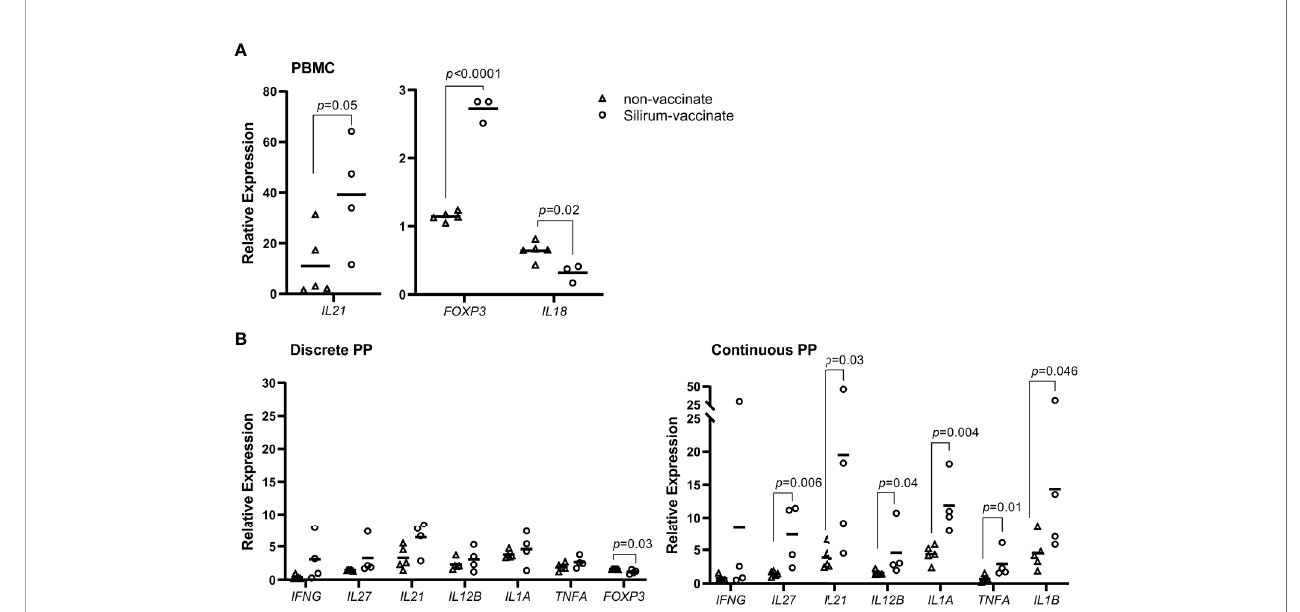
FIGURE 6 | Silirum vaccine-induced cytokine responses in peripheral blood and mucosal leukocytes. (A) Peripheral blood mononuclear cells (PBMCs) (5 x 10 6 cells) and (B) PP cells (2 x 10 6 cells) were isolated at 28 days post-infection from Silirum-vaccinated calves (n=3-4) and non-vaccinates (n=5) and re-stimulated ex vivo with Mycobacterium avium ssp. paratuberculosis (MAP) whole cell lysate (5 µg/ml) for 24 h. Transcript abundances for 17 cytokine genes ( Supplementary Table 1 ) were quanti fi ed in resting and re-stimulated cells, and relative expression calculated using 2 - DD Cq . Each data point represents the relative expression for an individual calf; horizontal line represents the mean value for each group. p values were determined using a Student ’ s t